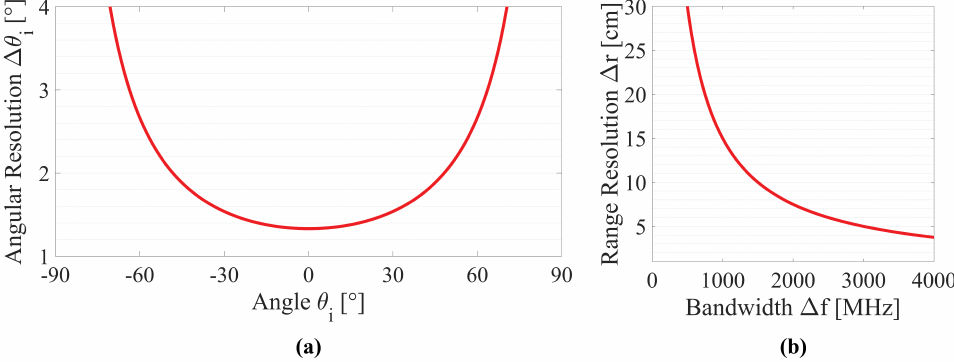
Figure 3. ( a ) Angular resolution ∆ θ i as a function of the angle of arrival θ i for a SAR instrument with 86 unique VA spaced by λ /2. ( b ) Range resolution ∆ r as a function of the bandwidth ∆ f for a SAR